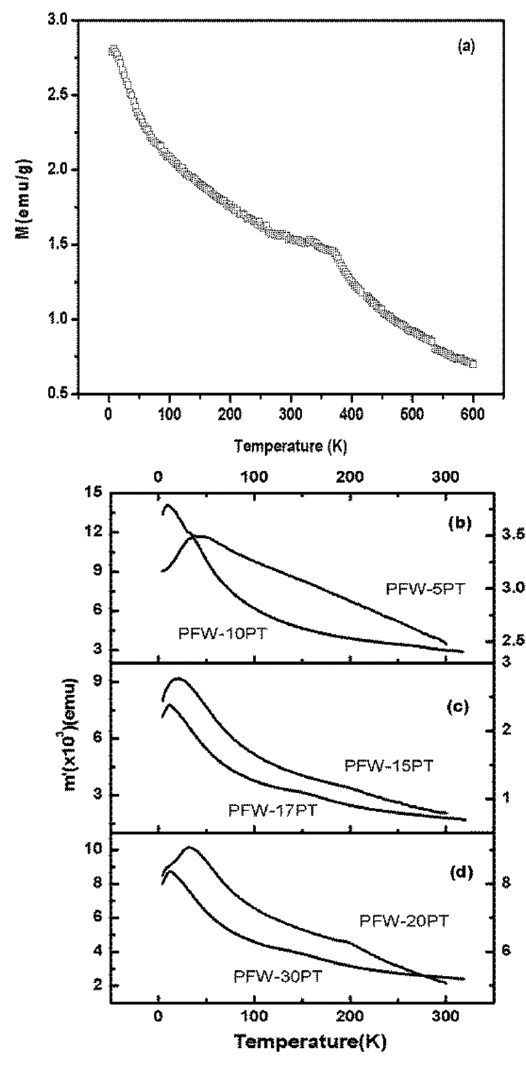
Figure 1. Temperature dependence of the magnetic moments M(T) (dc measurements) for PFW (a) and m’(T) (ac measurements) for PFW-PT system , x= 0.05 and 0.10 (b), 0.15 and 0.17(c) 0.20 and and 0.30